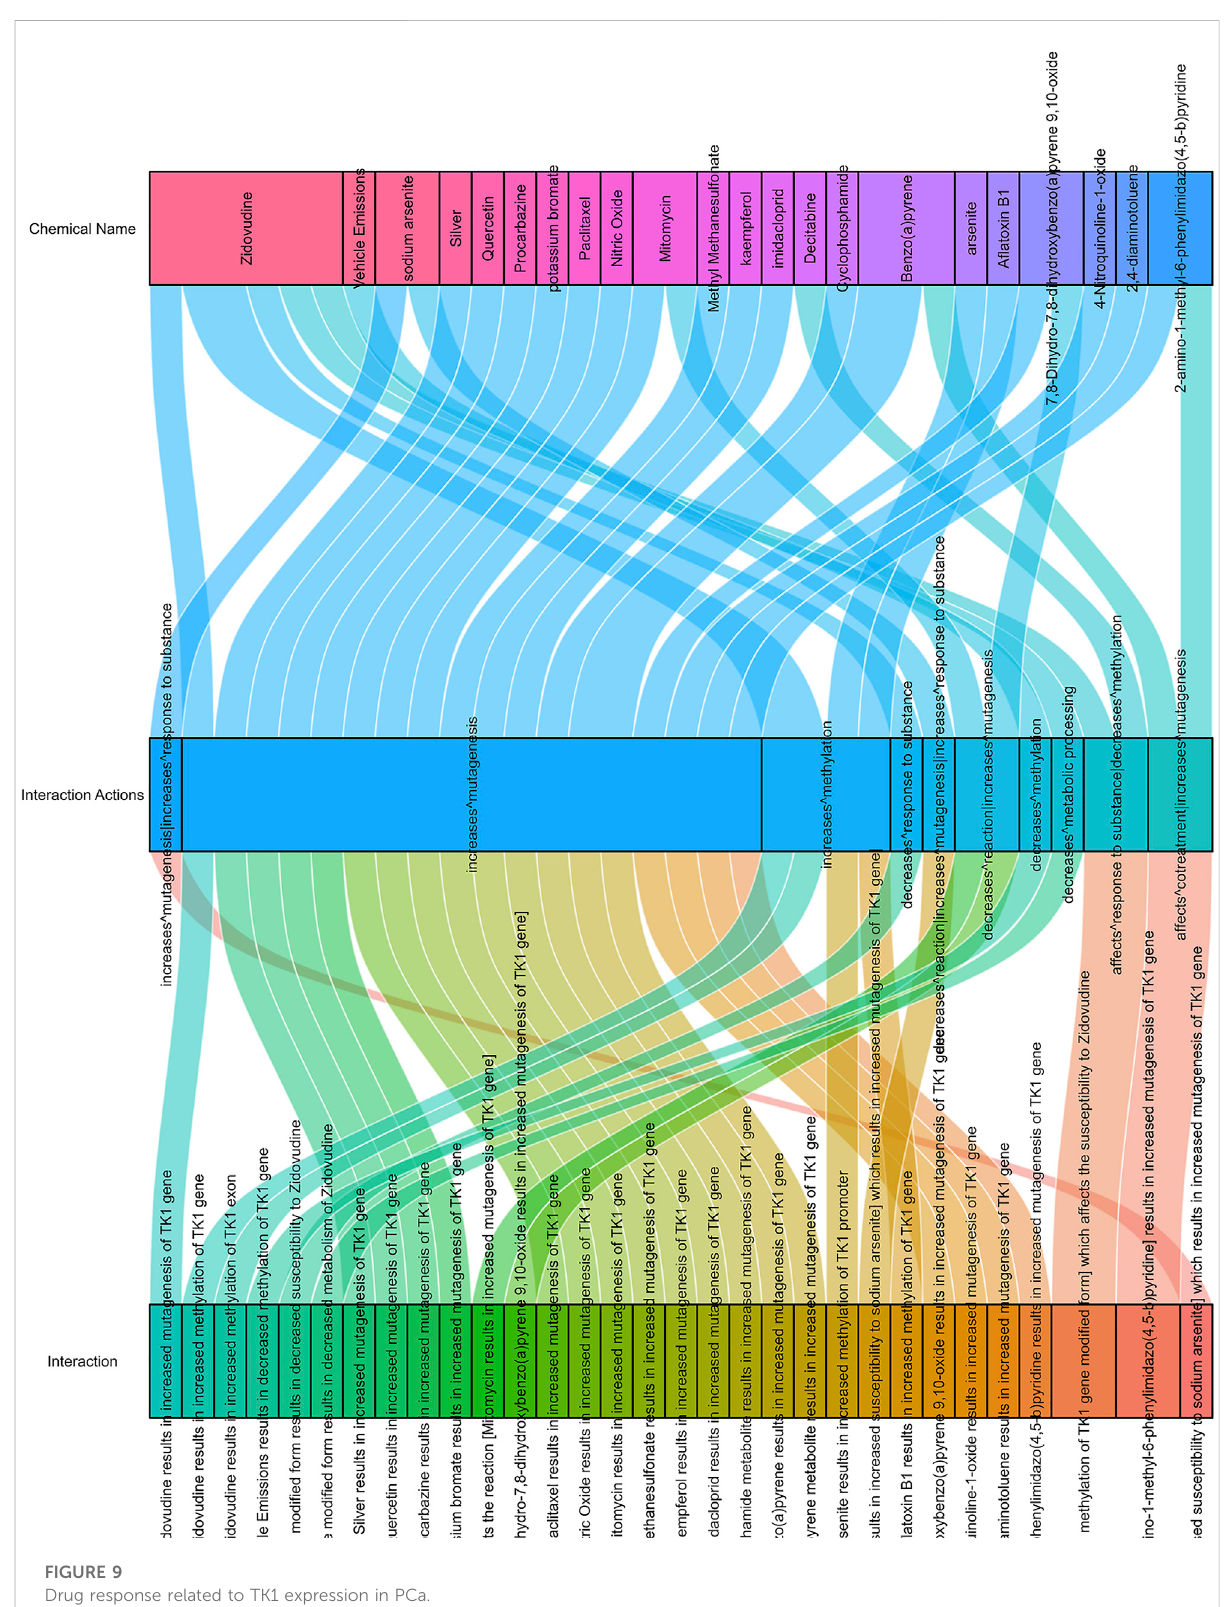
FIGURE 9 Drug response related to TK1 expression in